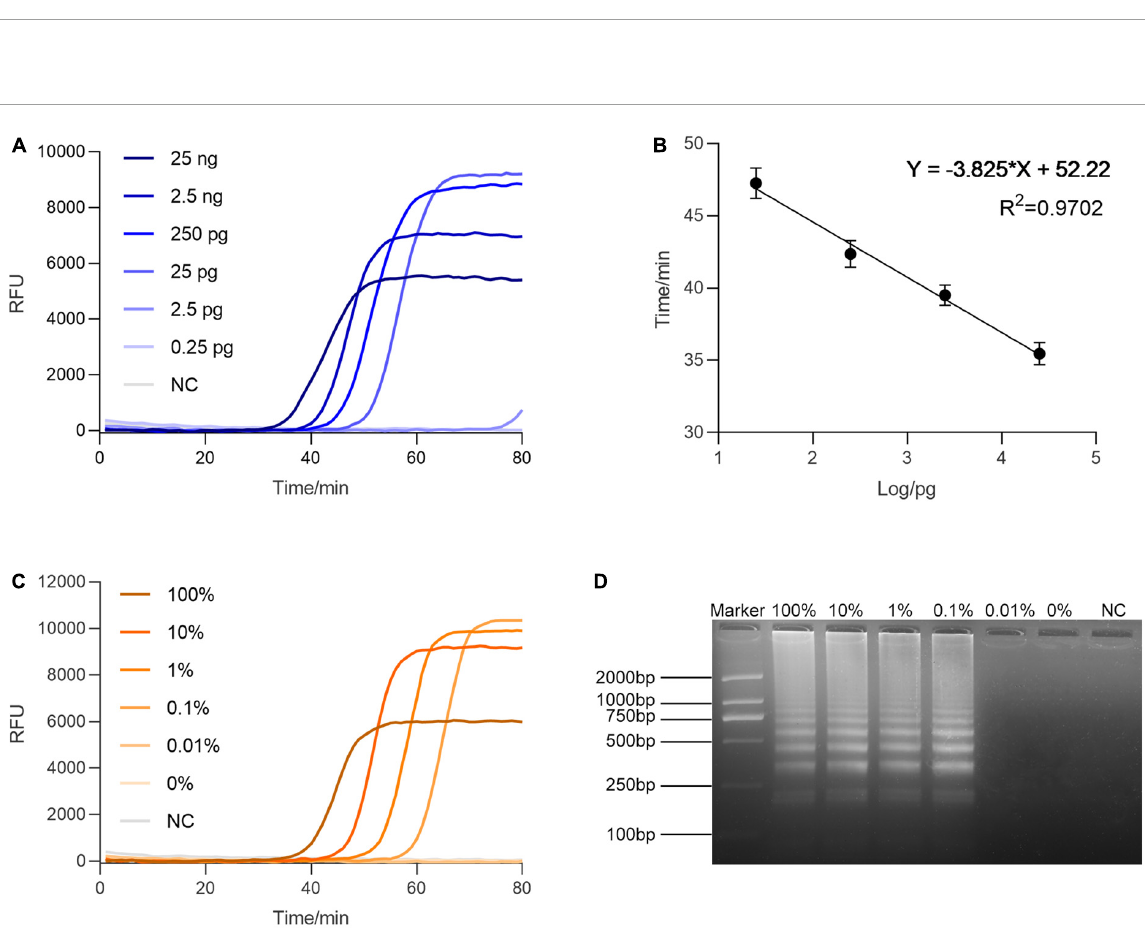
FIGURE3 Sensitivity analysis of real-time Recombinase Assisted Loop-mediated isothermal DNA Amplification (RALA). (A) Sensitivity of the method in the range of 25 ng–2.5 pg of BF cirrhosae genome. (B) The standard curve of the linear relation between the Tq value and the logarithm of the DNA quality in 25 ng–25 pg. The error bars are the standard deviation of two repetitive measurements. (C) Sensitivity analysis of real-time RALA with different percentages (100, 10, 1, 0.1, 0.01, 0%) of BF cirrhosae templates. (D) Gel electrophoresis analysis of the different percentages (100, 10, 1, 0.1, 0.01, 0%) of BF cirrhosae amplification